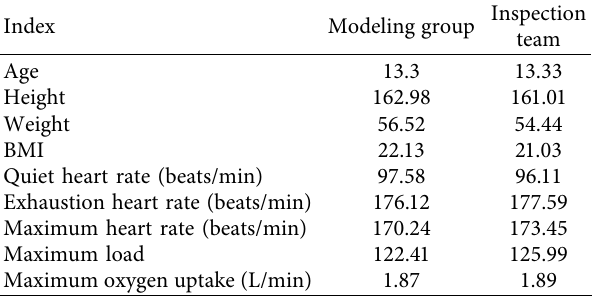
Table 1: Descriptive statistics of each index of